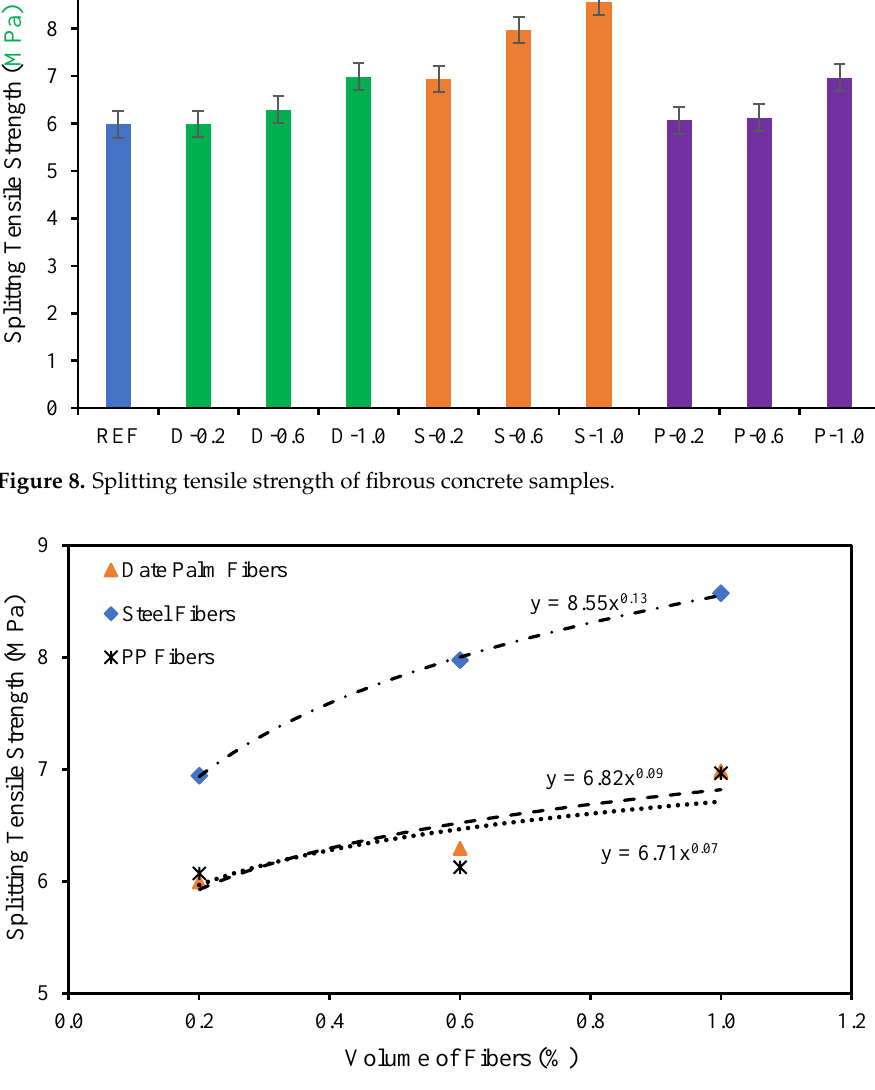
Figure 8. Splitting tensile strength of fibrous concrete samples.